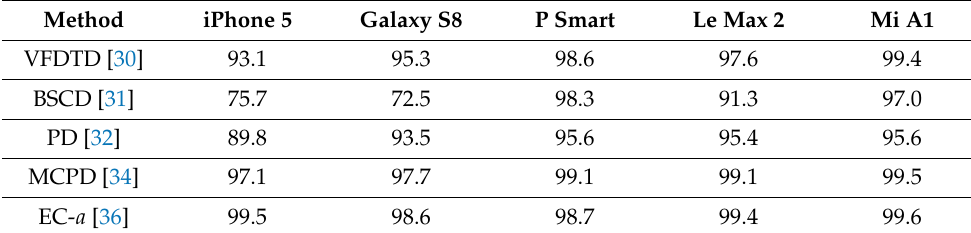
Table 2. Transient starting point detection rates (%) at low SNR.